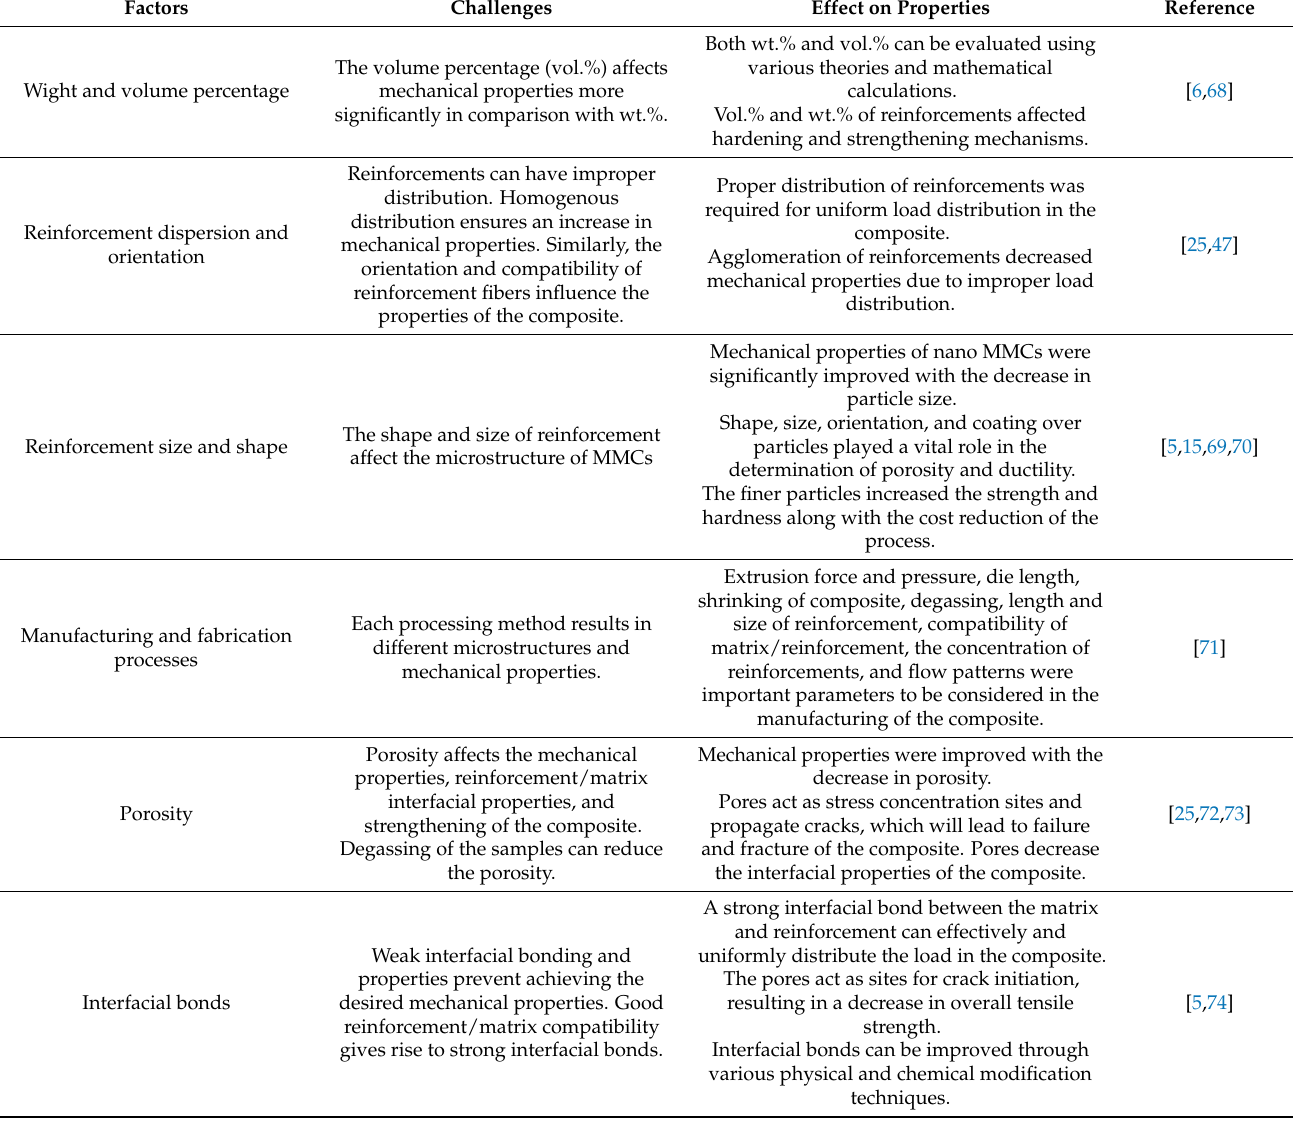
Table 8. Factors affecting physical and mechanical properties of metallic